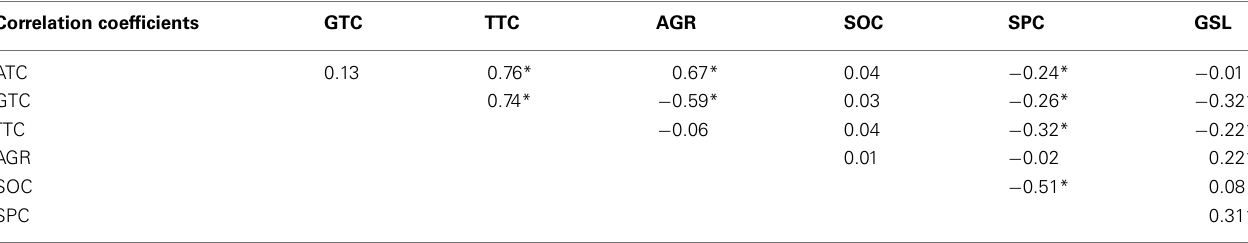
Table 3 | Correlation coefficients of α - and γ -tocopherol, total tocopherol content, tocopherol composition, glucosinolate, oil, and protein content of 96 accessions in panel 1.